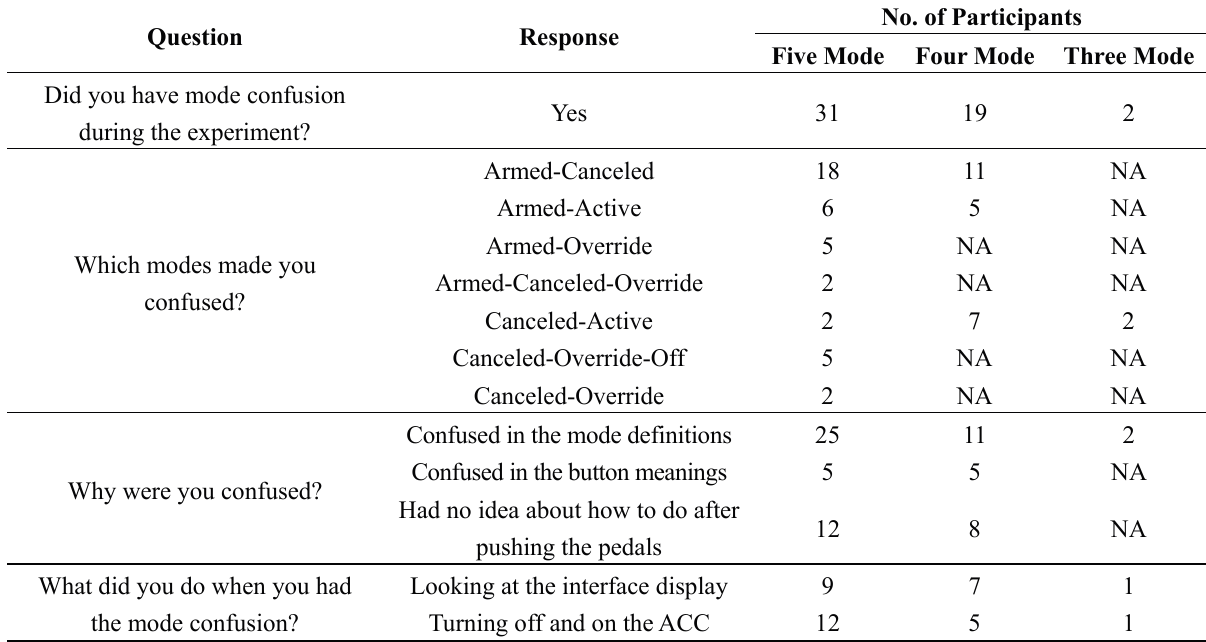
Table 11. Questions and responses after experiments with the three-, four-, and five-mode ACC